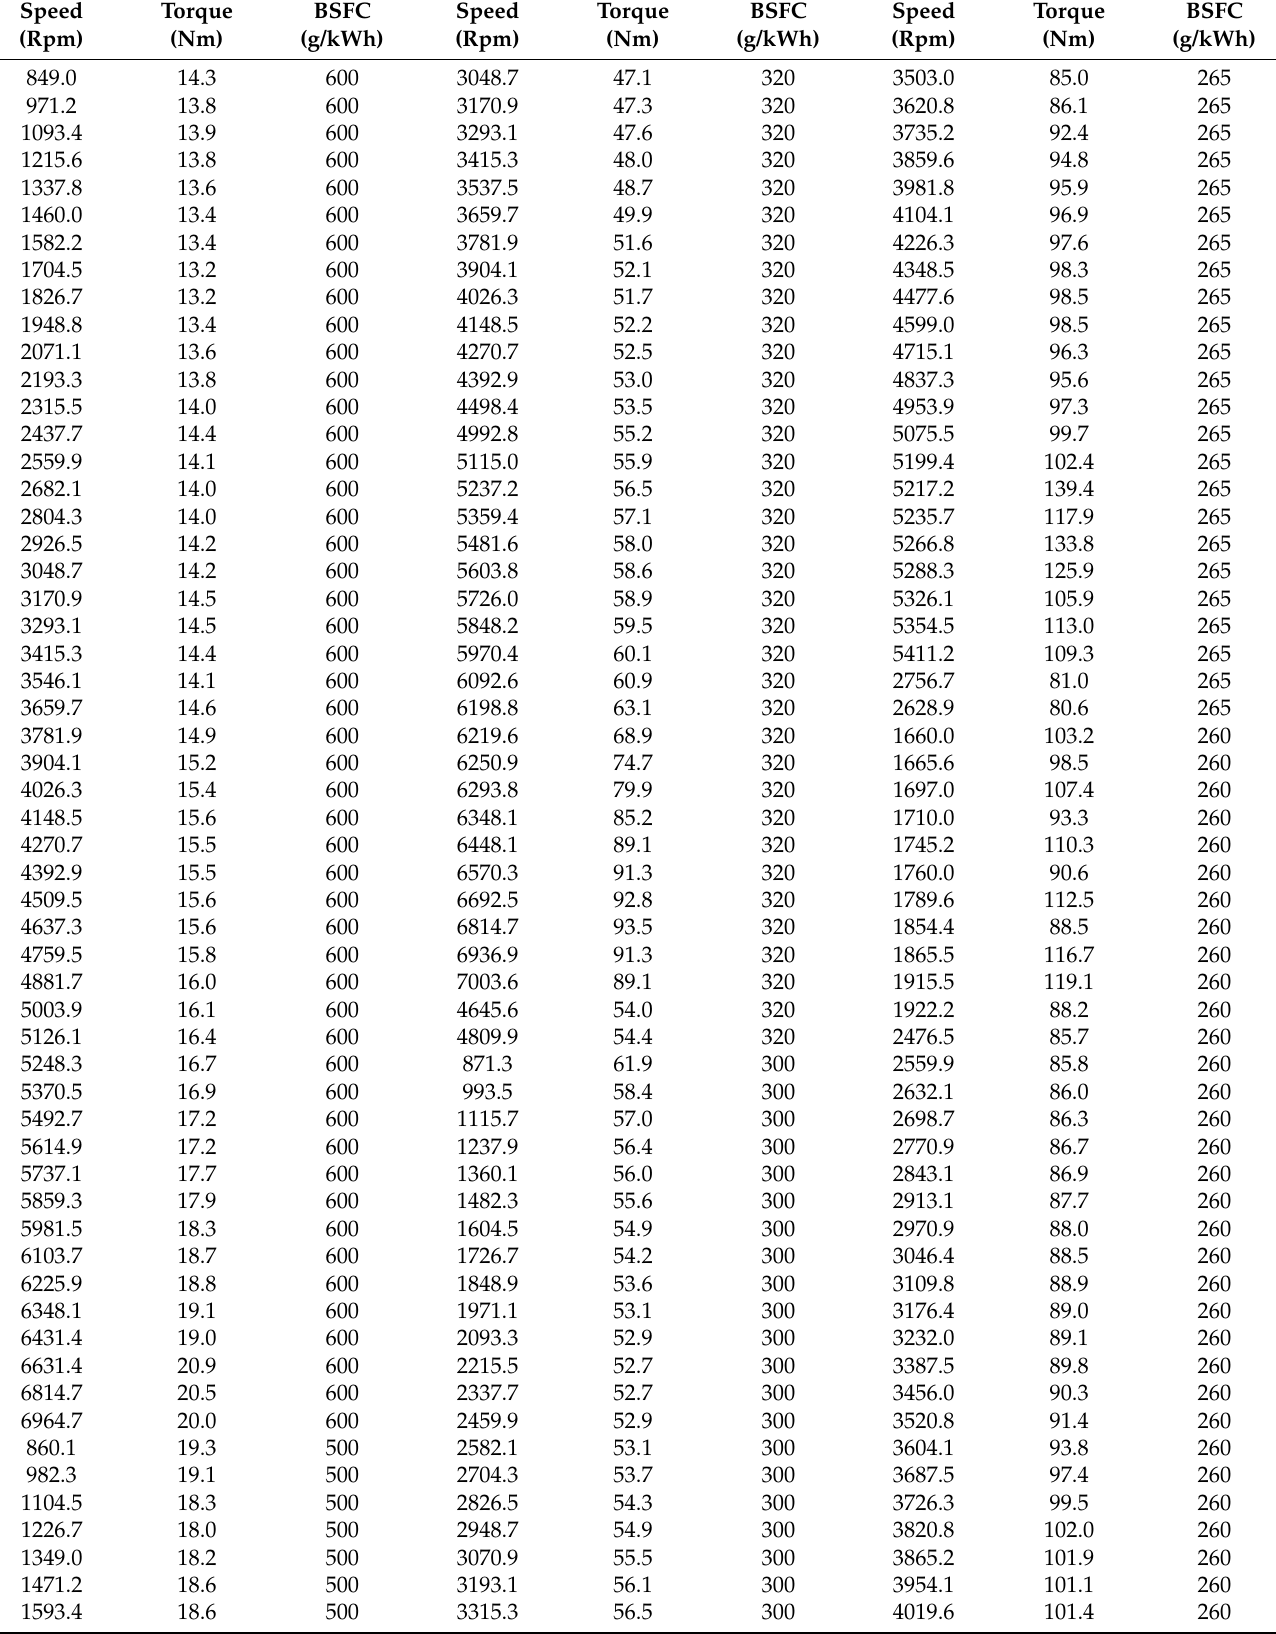
Table A1. BSFC map numerical values function of engine speed and engine